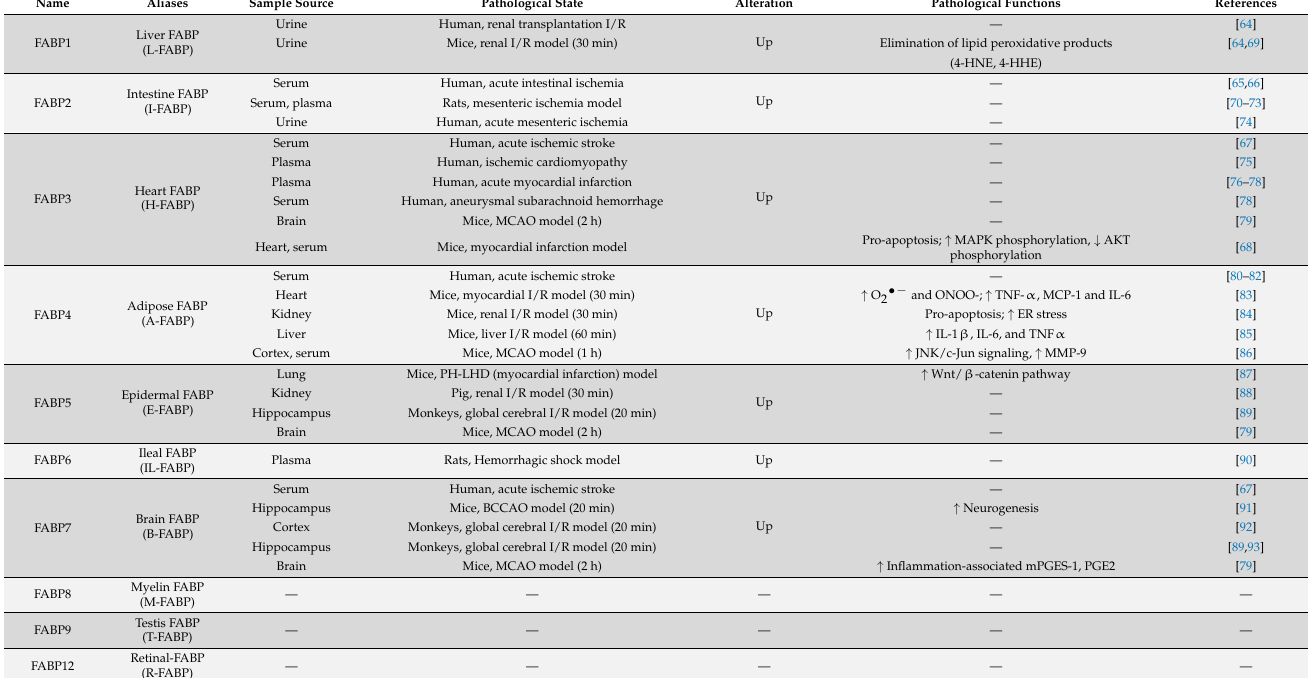
“Human” represents clinical research data of patients, while preclinical data refers to animal “model” experi- ments in the table. “—” means no data available. “ ↑ ” means up-regulation and “ ↓ ” means down-regulation. MCAO: Middle cerebral artery occlusion; BCCAO: Bilateral common carotid artery occlusion; 4-HNE: I/R: Is- chemia/Reperfusion; PH-LHD: Pulmonary hypertension-left heart disease; 4-HNE: 4-Hydroxynonenal;